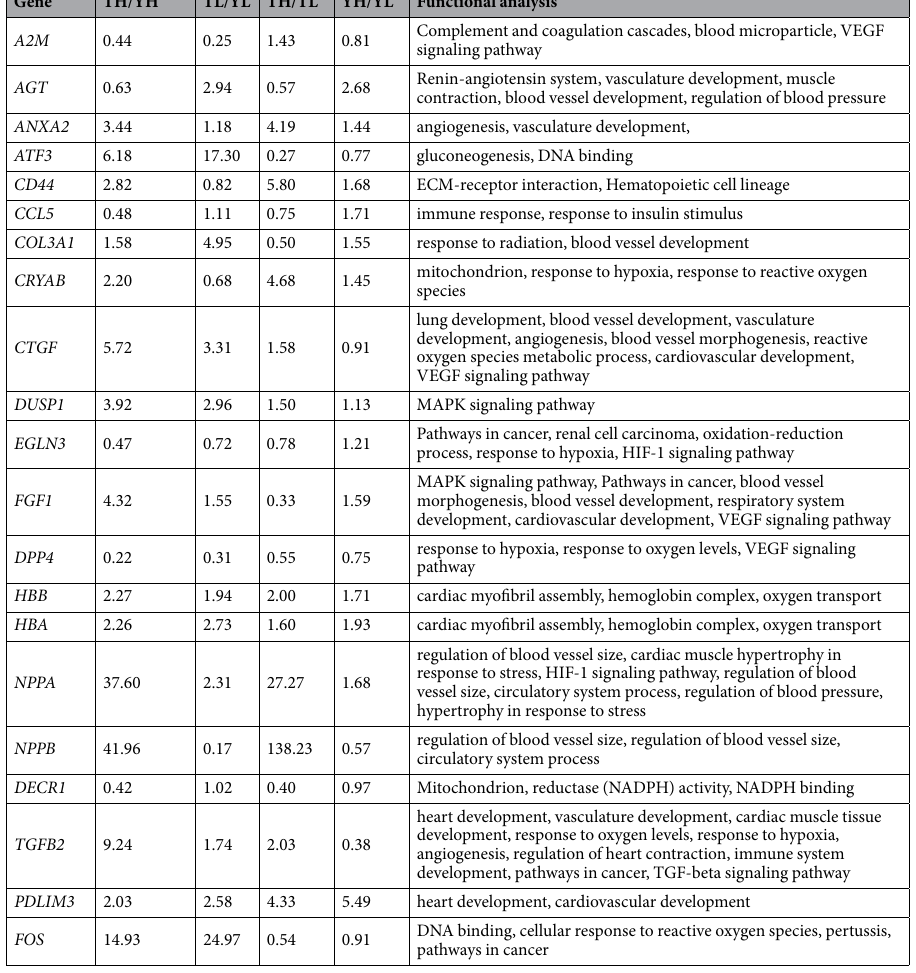
Table 1. Potential key differentially expressed genes (DEGs) and their functions related to hypoxic adaption in the Tibetan pig. TH, Tibetan highland pig; TL, Tibetan lowland pig; YH, Yorkshire highland pig; YL, Yorkshire lowland